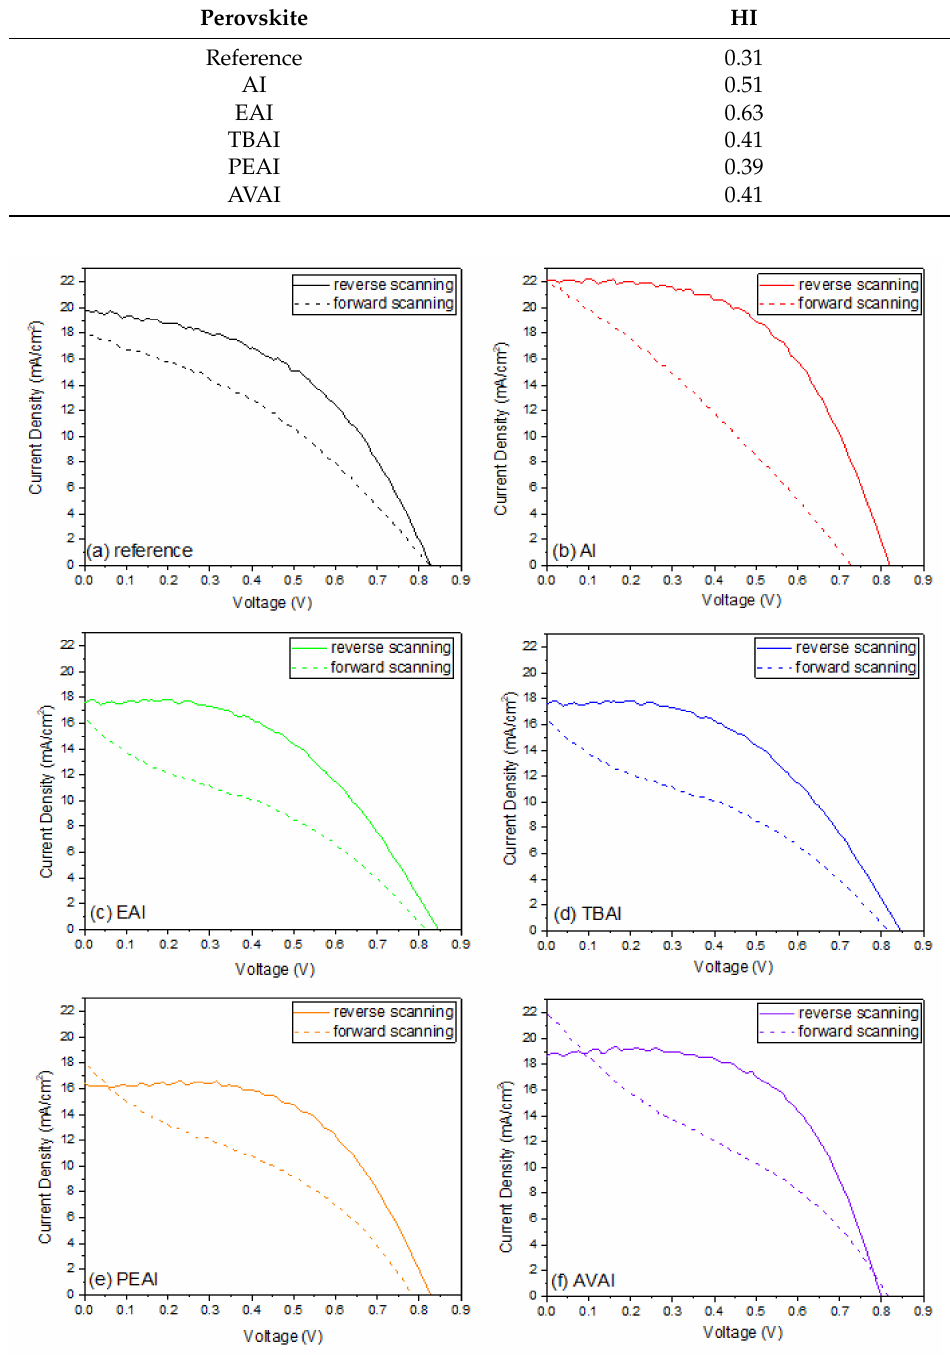
Figure 13. The J-V curves of the C-PSCs prepared with the reference and the post-treated devices, with the different post-treatment agents ( a ) reference; ( b ) ammonium iodide; ( c ) ethyl ammonium iodide; ( d ) tetra butyl ammonium iodide; ( e ) phenethyl ammonium iodide; and ( f ) 5-ammonium valeric acid